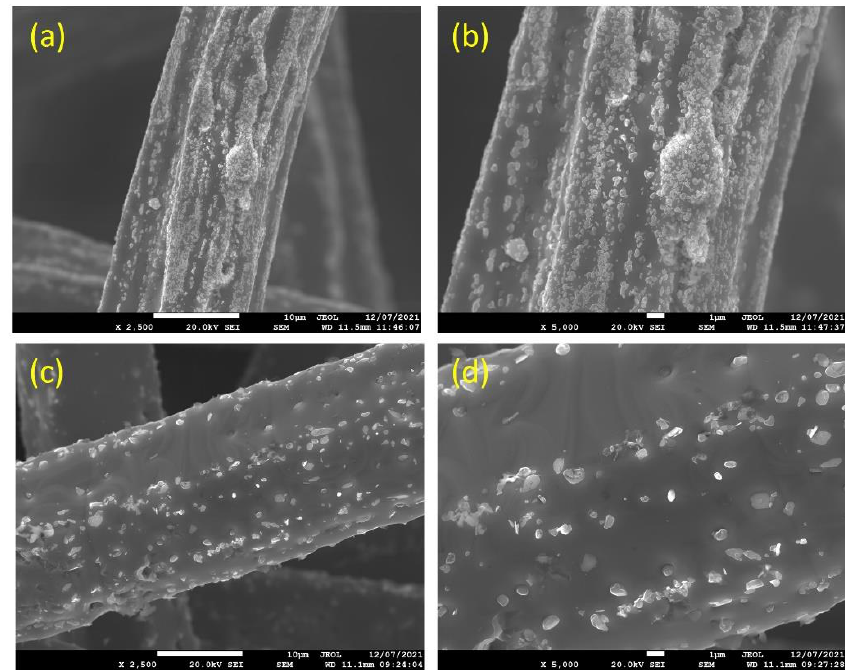
Figure 3. Without heat treatment, SEM micrographs of the FeCrAl fibers at different magnifications: ( a ) ×2500 and ( b ) ×5000 for the 12 μm fibers; ( c ) ×2500 and ( d ) ×5000 for the 17 μm